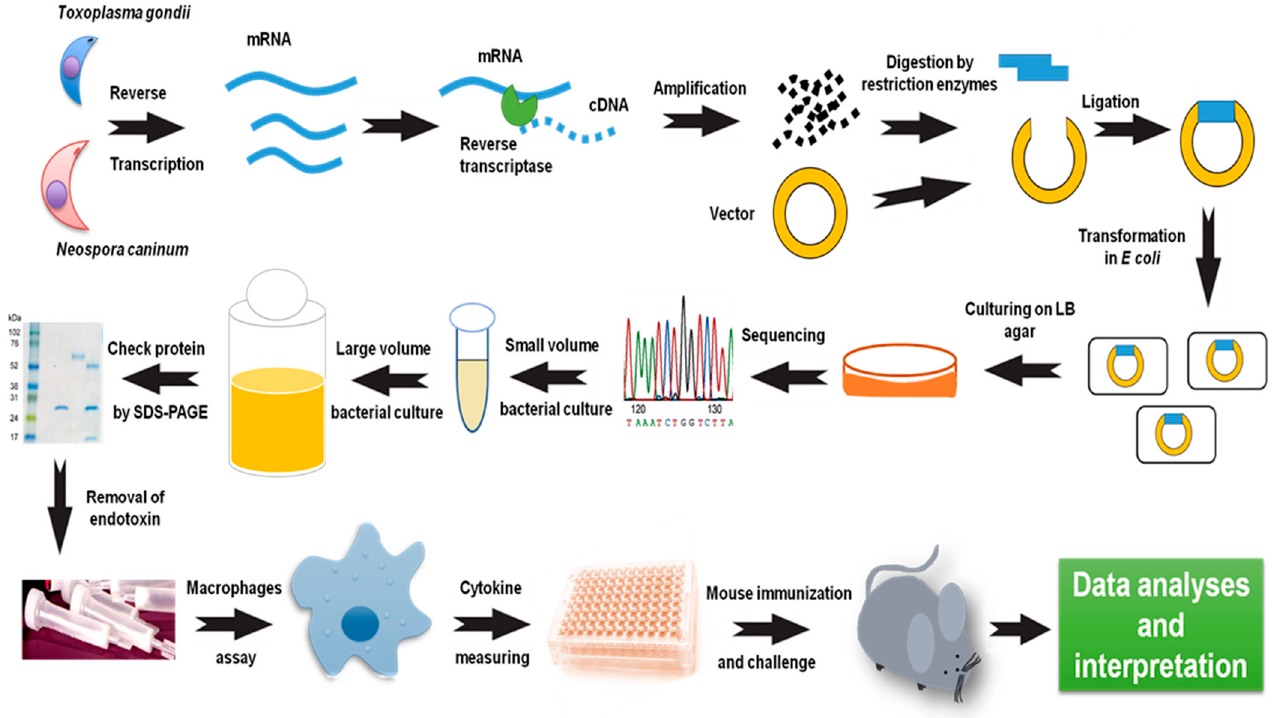
Figure 4. Main steps of vaccine antigen preparation and evaluation. Recombinant protein is prepared based on the cDNA library via synthesis of cDNA from mRNA using reverse transcriptase. Then, the target is amplified using specific primers and conventional polymerase chain reaction. Molecular cloning of the target gene is started by digestion using restriction enzymes, including the target vectors (e.g., pGEX-4T or pET). After ligation, the designed vector with the gene is inserted in cloning Escherichia coli ( E. coli ) as DH5 α and plated on luria bertani agar. Positive colonies are confirmed by sequencing and then transformed into protein expression E. coli BL21. Positive colonies are tested for protein expression using a small volume culture. Protein expression is started by culturing on a large volume culture (0.5–1 L). Recombinant protein purity and quantity is tested via running on SDS-PAGE. Endotoxin is removed from the obtained protein before in vitro testing on macrophages and in vivo assessment in mice. Successful vaccine antigen can be predicted through macrophage production of IL-12 and confirmed via prolongation of mouse survival after the challenge with a parasite.